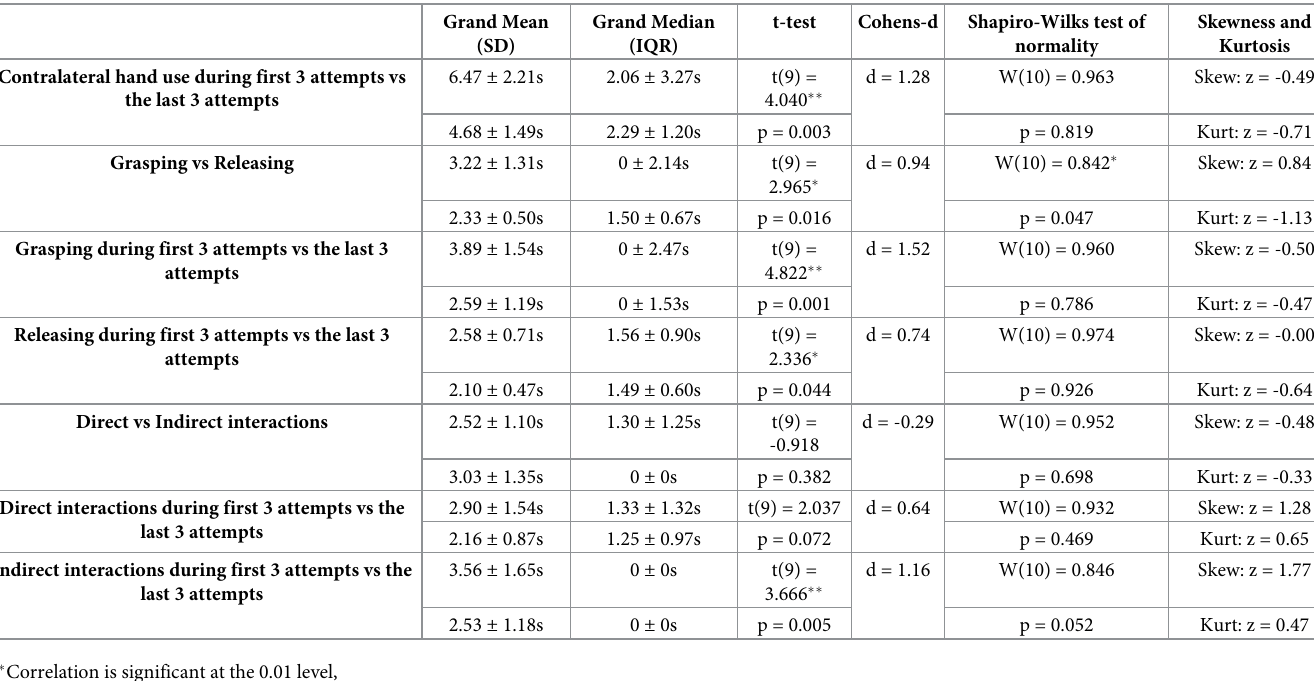
Table 2. Summary statistics relating to contralateral hand use.